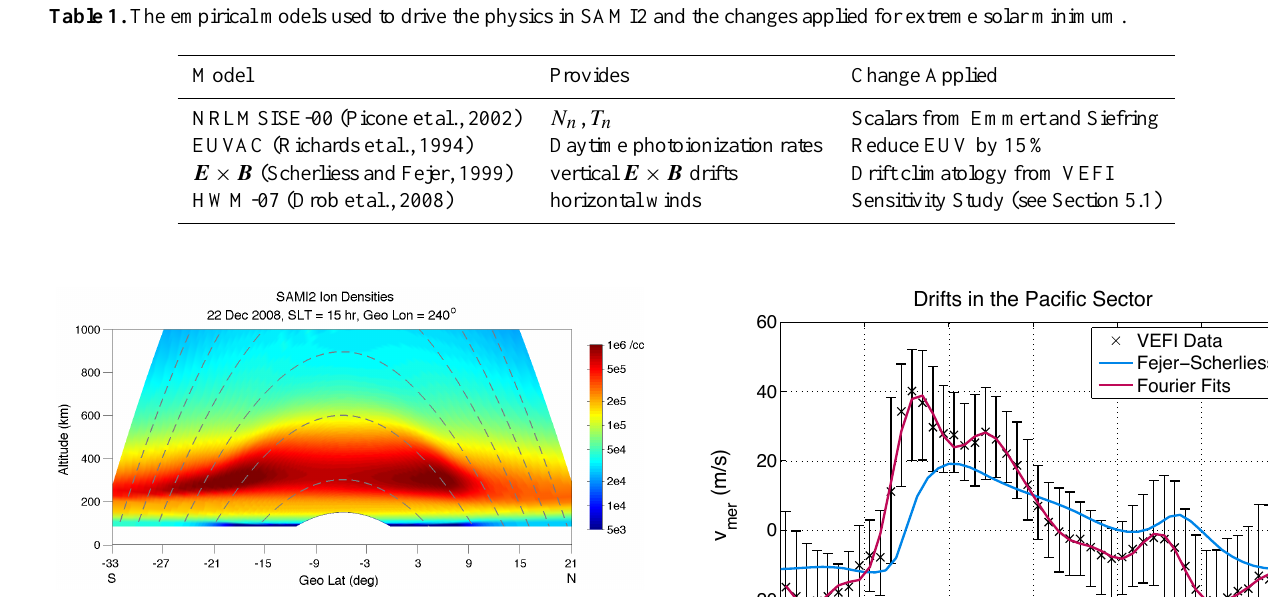
Fig. 1. The afternoon ion densities as predicted by SAMI2 for a two-dimensional stack of geomagnetic field lines near 240 degrees geographic longitude. The dashed lines represent field lines every 300km. Fig. 2. The median vertical E × B drifts as measured by VEFI com- pared with the Fejer-Scherliess model for low solar activity. The Fig. 2. The median vertical E × B drifts as measured by VEFI compared with the Fejer-Scherliess model for vertical bars represent the upper and lower quartiles of the low solar activity. The vertical bars represent the upper and lower quartiles of the data.